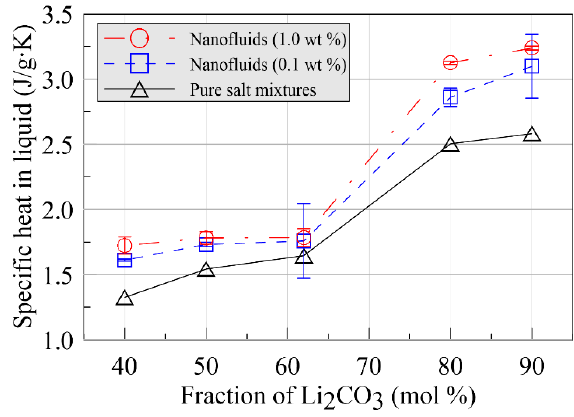
Figure 4. Specific heat of pure carbonate salt mixtures and nanofluids in the liquid phase.